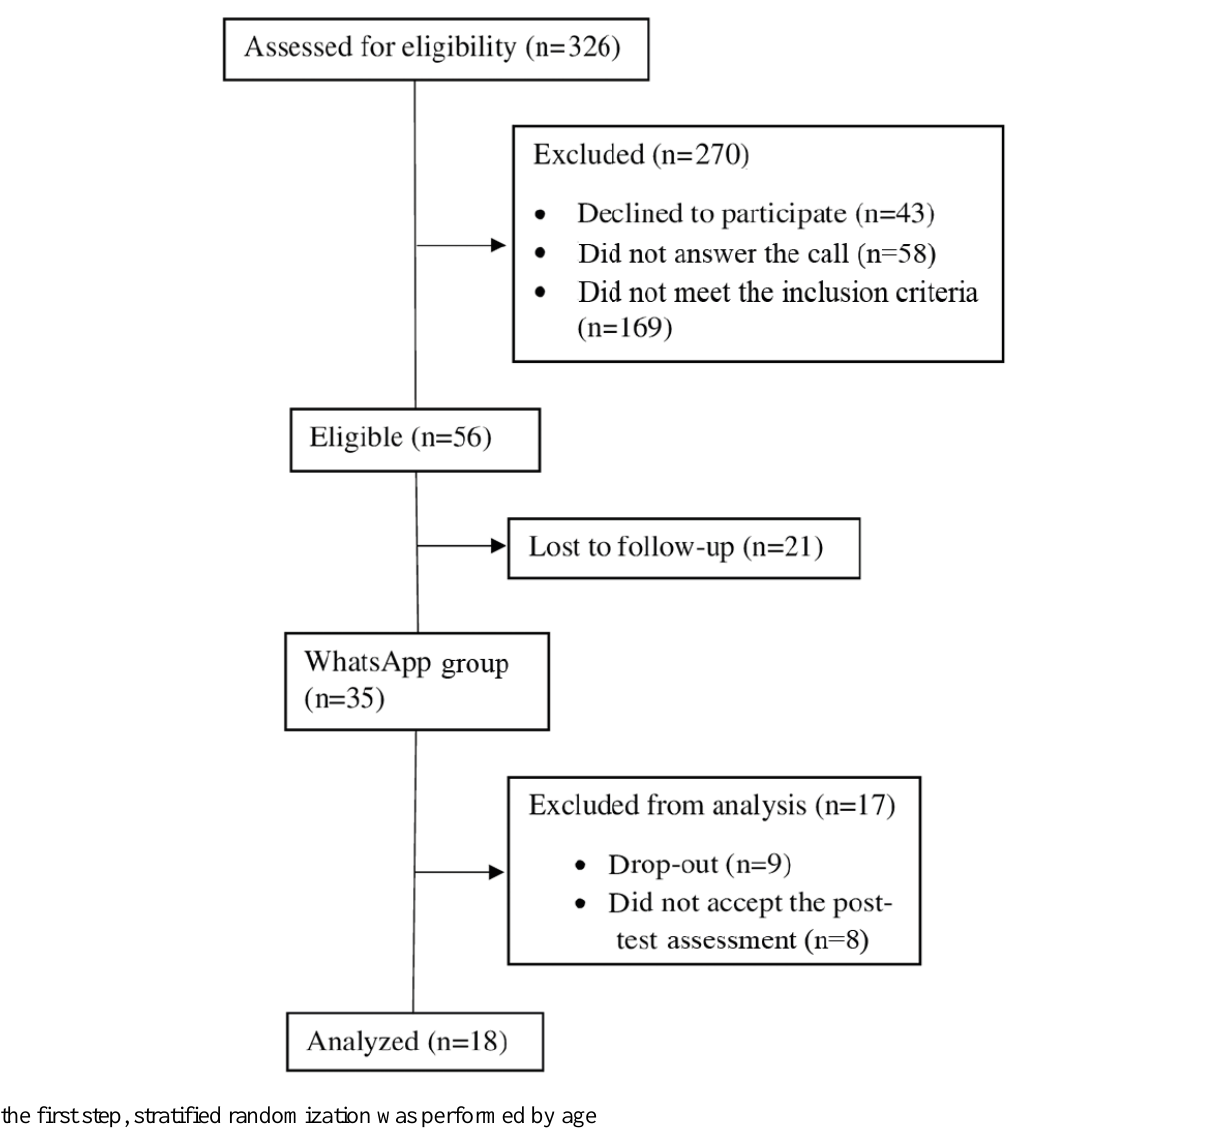
Figure 1. Flow of participants throughout the